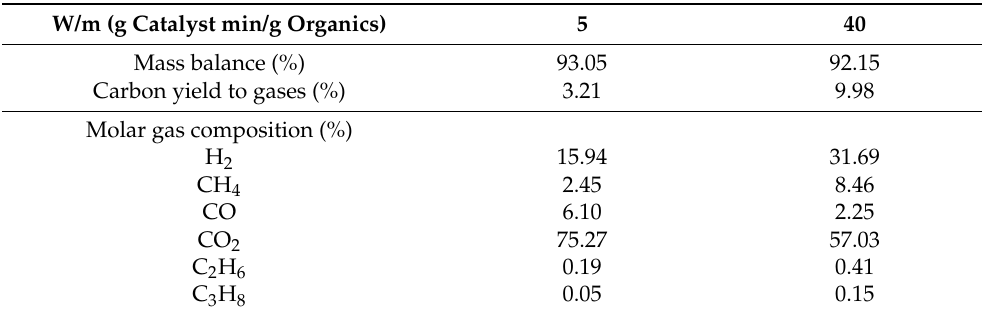
Table 6. Results of the product gas obtained in the APR experiments of a real aqueous fraction of bio-oil (T = 227 ◦ C, 40 bar, Ni-Co/Al-Mg catalyst, 1 mL/min aqueous feeding rate). W/m (g Catalyst min/g